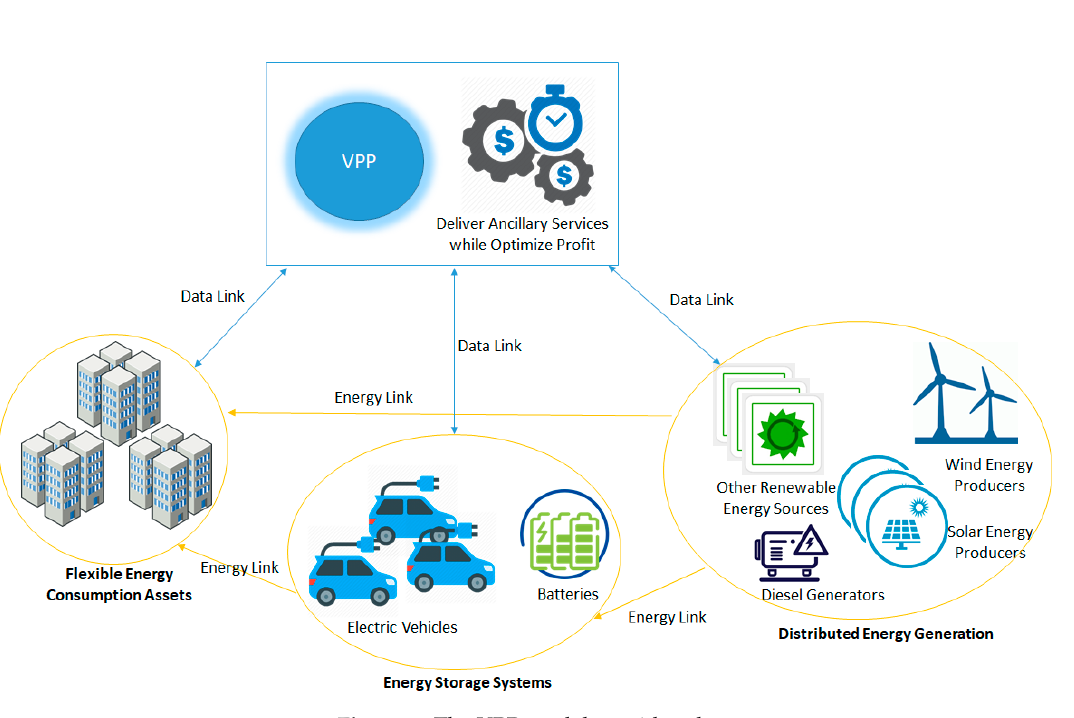
Figure 2. The VPP model considered.